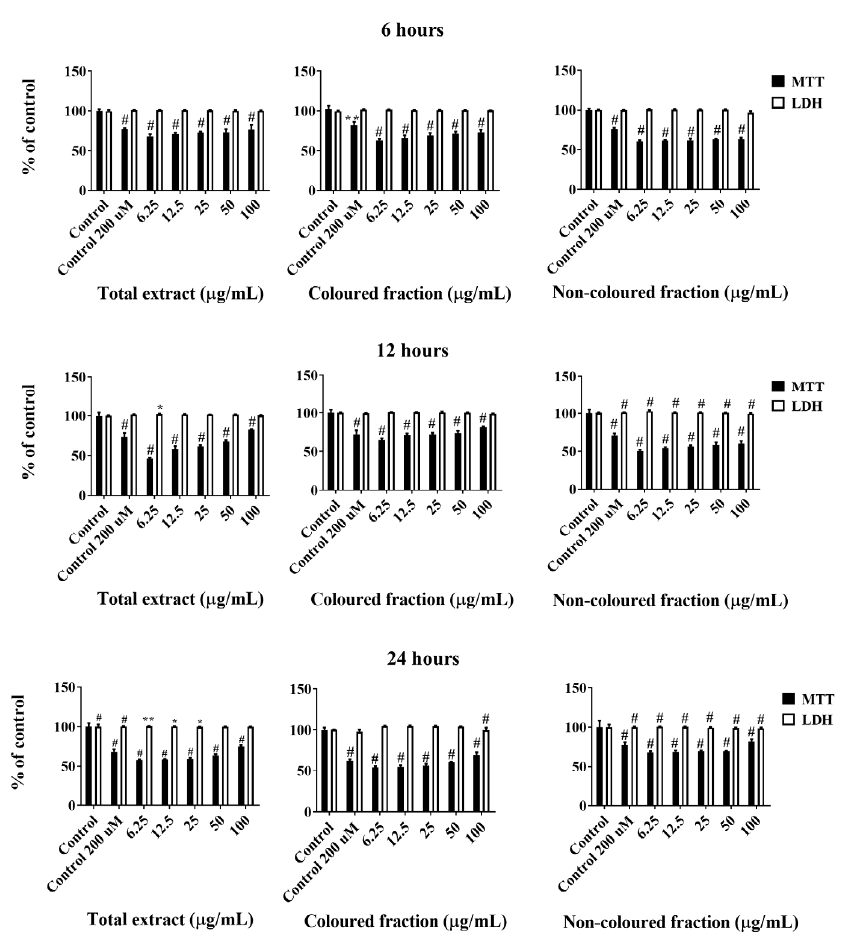
Figure 7. Viability of HepG2 cells assessed by 3-(4,5-dimethylthiazol-2-yl)-2,5-diphenyltetrazolium bromide (MTT) reduction and lactate dehydrogenase (LDH) leakage assays. Cells were pre-treated for 24 h with each extract and then incubated with 200 µM of hydrogen peroxide (H 2 O 2 ) for further 6, 12 and 24 h. Values show mean ± SEM of six independent assays performed in triplicate ( * p < 0.05, ** p < 0.01 and # p < 0.0001 compared to the respective control without H 2 O 2 ).